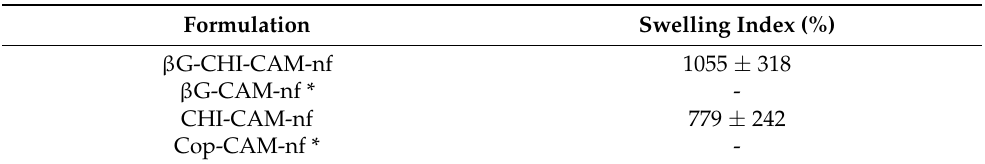
Table 4. Swelling index of nanofibers containing chloramphenicol. Results are presented as mean ± SD ( n = 3). The swelling index of nanofibers marked with * could not be